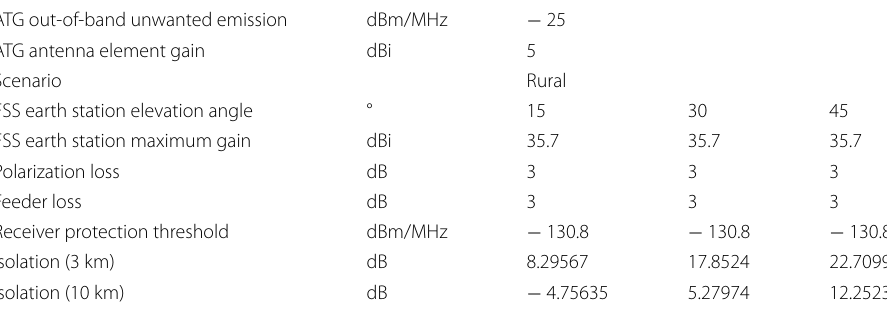
Table 7 Deterministic calculation conclusion—rural ATG out-of-band unwanted